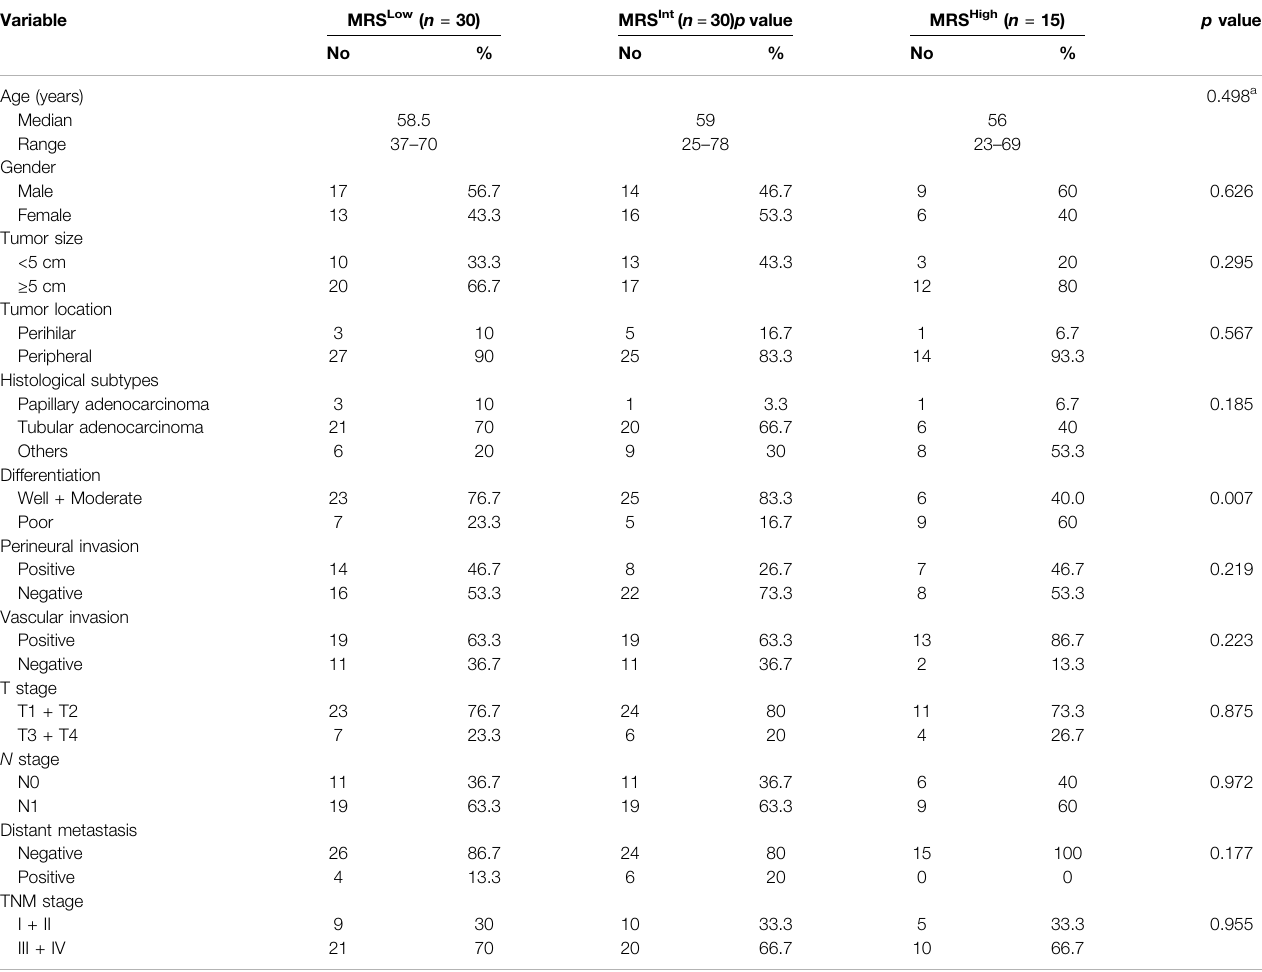
TABLE 2 | Correlation between the MRS Grouping and clinicopathological parameters. Variable